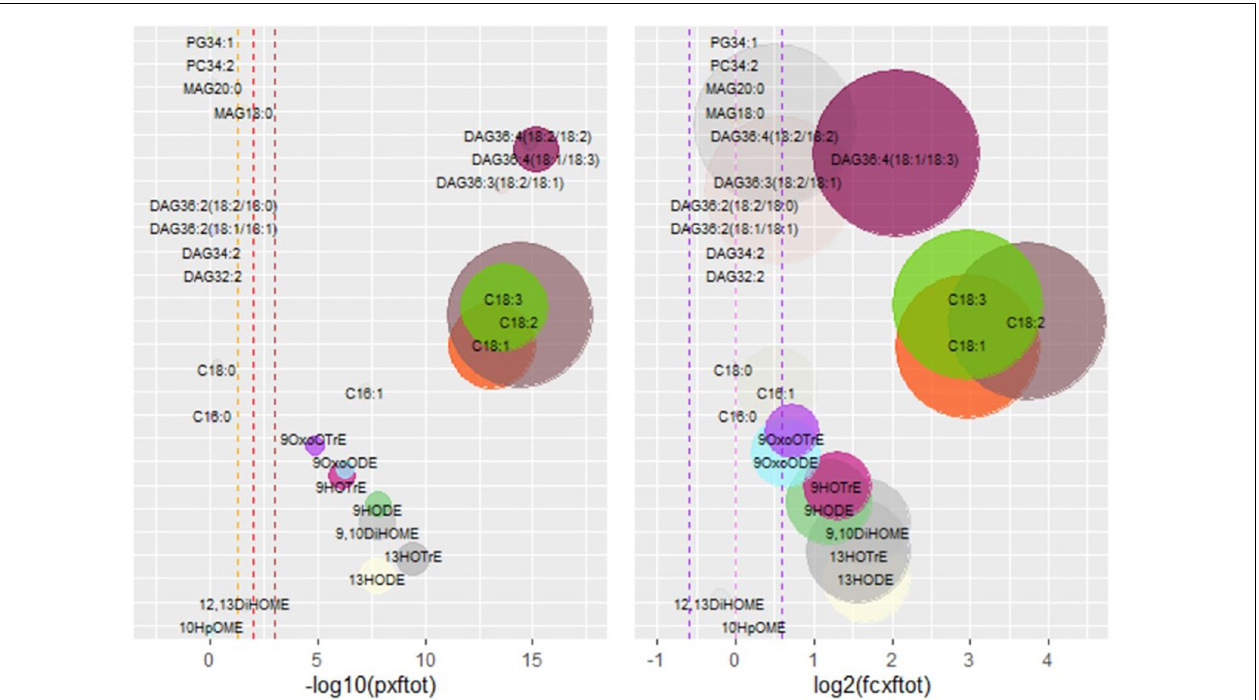
FIGURE 1 | Xf -positive vs. Xf -negative (X vs. H) analysis of the lipid dataset. The left panel shows statistically significant compounds: on the x-axis, there is the − log10( p -value), on the y-axis compound names. The vertical dashed lines correspond to, respectively, − log10(0.05), − log10(0.01), and − log10(0.001). Compounds under the first threshold are represented as transparent, compounds above the threshold are in full colors. Circle dimensions are proportional to fold changes. On the right panel, x-axis there is the log2(fold-change), on the y-axis compound names. The right panel points out compounds with the biggest fold changes, represented in full colors, while compounds with a fold change ≥ 1.5 or ≤ 1.5 are transparent. Circle dimension is proportional to − log10( p -value). RF-based feature selection is used to obtain the top five predictors for machine learning analysis and, after five times 10-fold-cross-validation, the chosen features are indicated in Supplementary Figure 4 and Supplementary Table 2 . These features are used to train three learning models based on different algorithms: RF, SVM, and NNet. The models are validated through 10-fold-cross-validation five times, and they all are performing well, with AUCs > 0.9: RF is the best model ( Supplementary Figures 5A–C ). The importance of the selected features ( Supplementary Table 2 ) in X vs. H classification task is confirmed by applying the trained models on the test set with a default threshold of 0.5. The metrics for RF are very good, while SVM and NNET are less performing even though significant ( Supplementary Table 1 ). phosphatidylglycerol (PG), phosphatidylcholine (PC), monoacylglycerol (MAG), diacylglycerol (DAG), stearic acid (C18:0), oleic acid (C18:1), linoleic acid (C18:2), linolenic acid (C18:3), palmitic acid (C16:0), palmitoleic acid (C16:1), oxo-octadecatrienoic acid (OxoOTrE), oxo-octadecenoic acid (OxoODE), hydroperoxyoctatrienoic acid (HOTrE), hydroxyoctadecenoic acid (HODE), (DiHOME), hydroperoxyoctamonoenoic acid (HpOME). Notation for FAs and oxylipins (OM/D/TrE) is reported as indicating the carbon number (CN) and the number of double bond (DB) equivalents (e.g., C18:1 is oleic acid and HODE is